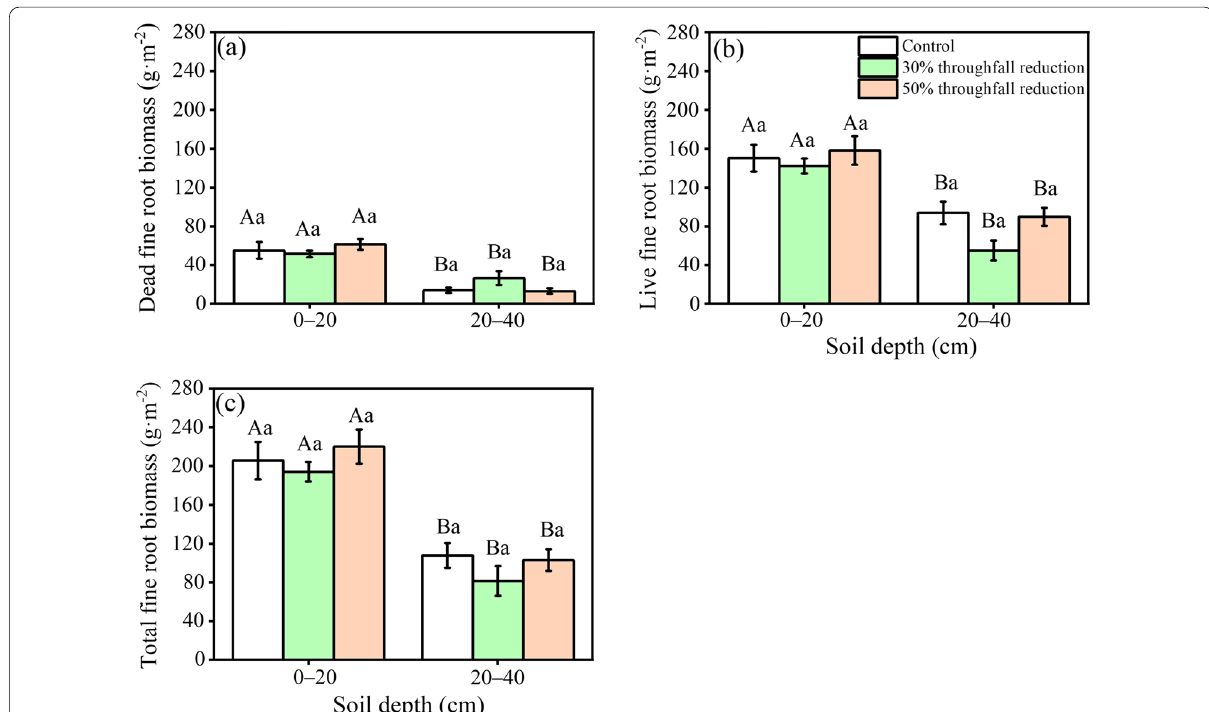
Fig. 6 Effect of drought on dead, live and total fine‑root biomass (mean the bars indicate significant differences between soil layers at each drought treatment, and different lowercase letters above the bars indicate significant differences among three drought treatments at each soil